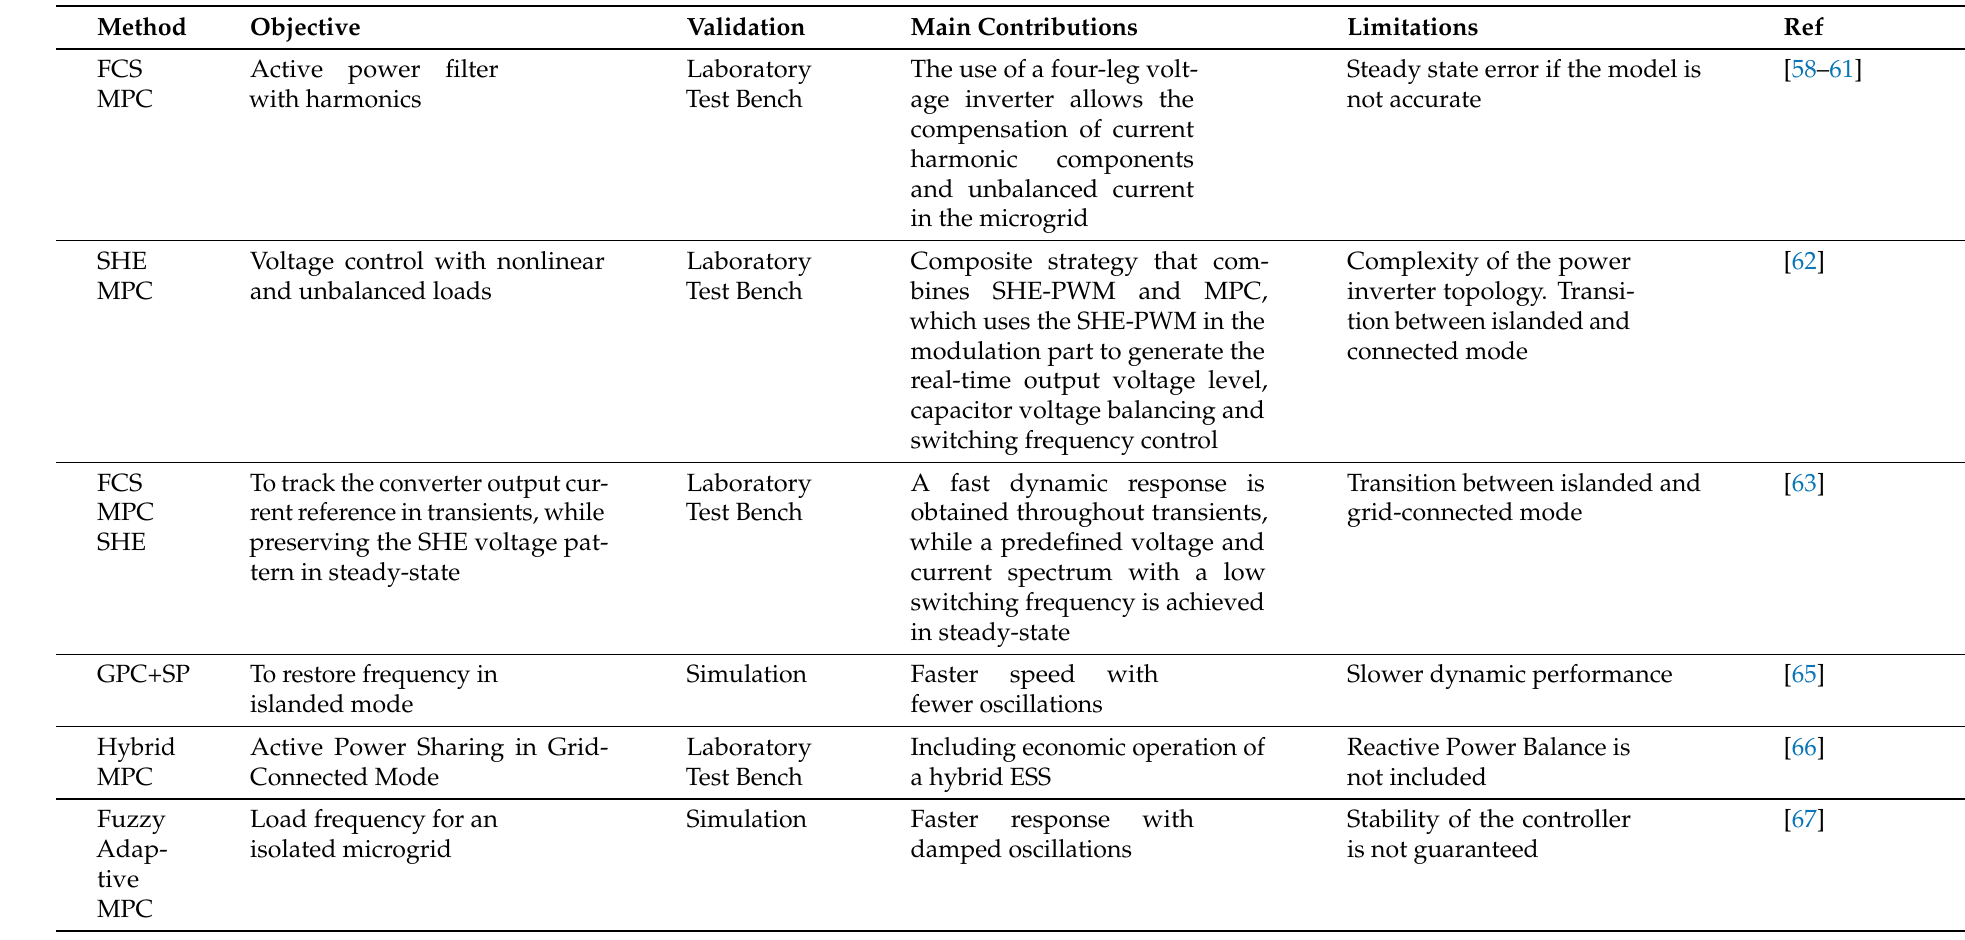
Table 1. Application of MPC schemes for power quality